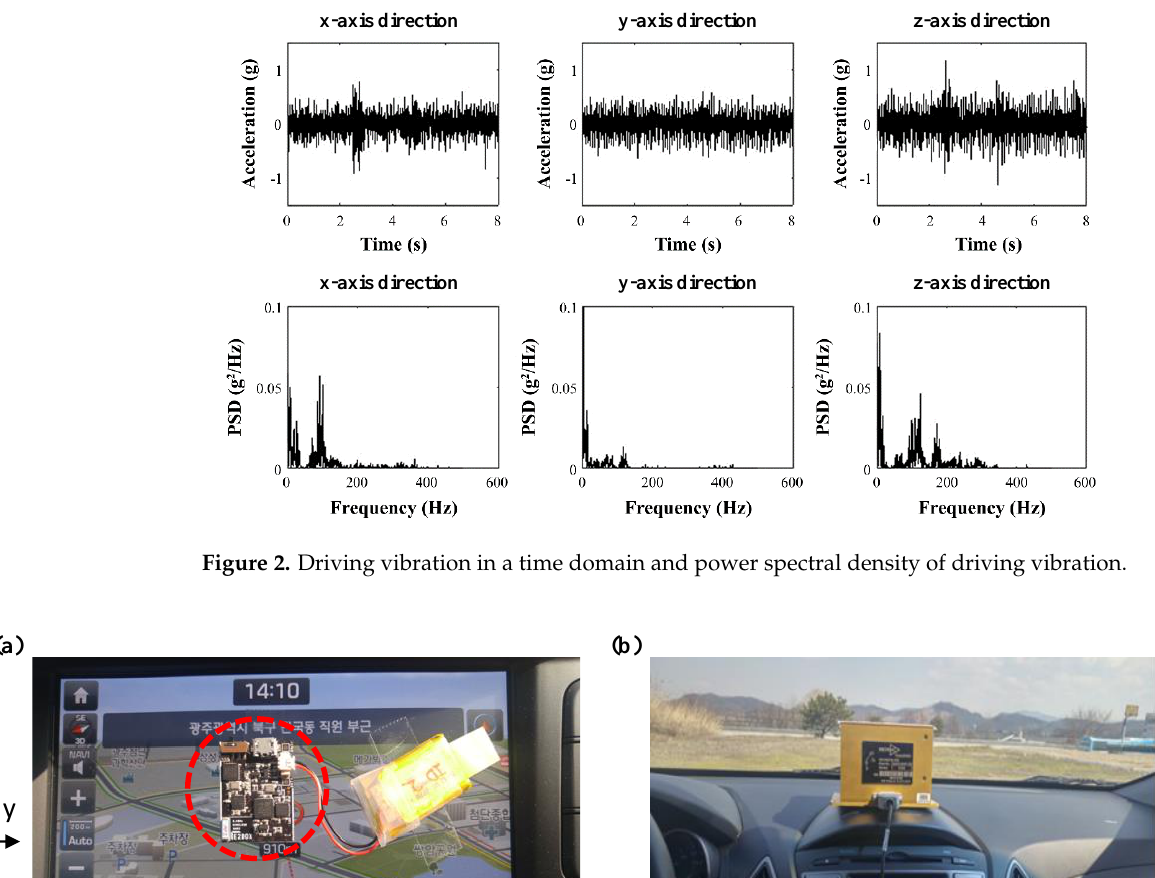
Figure 2. Driving vibration in time domain and power spectral density of driving vibration.